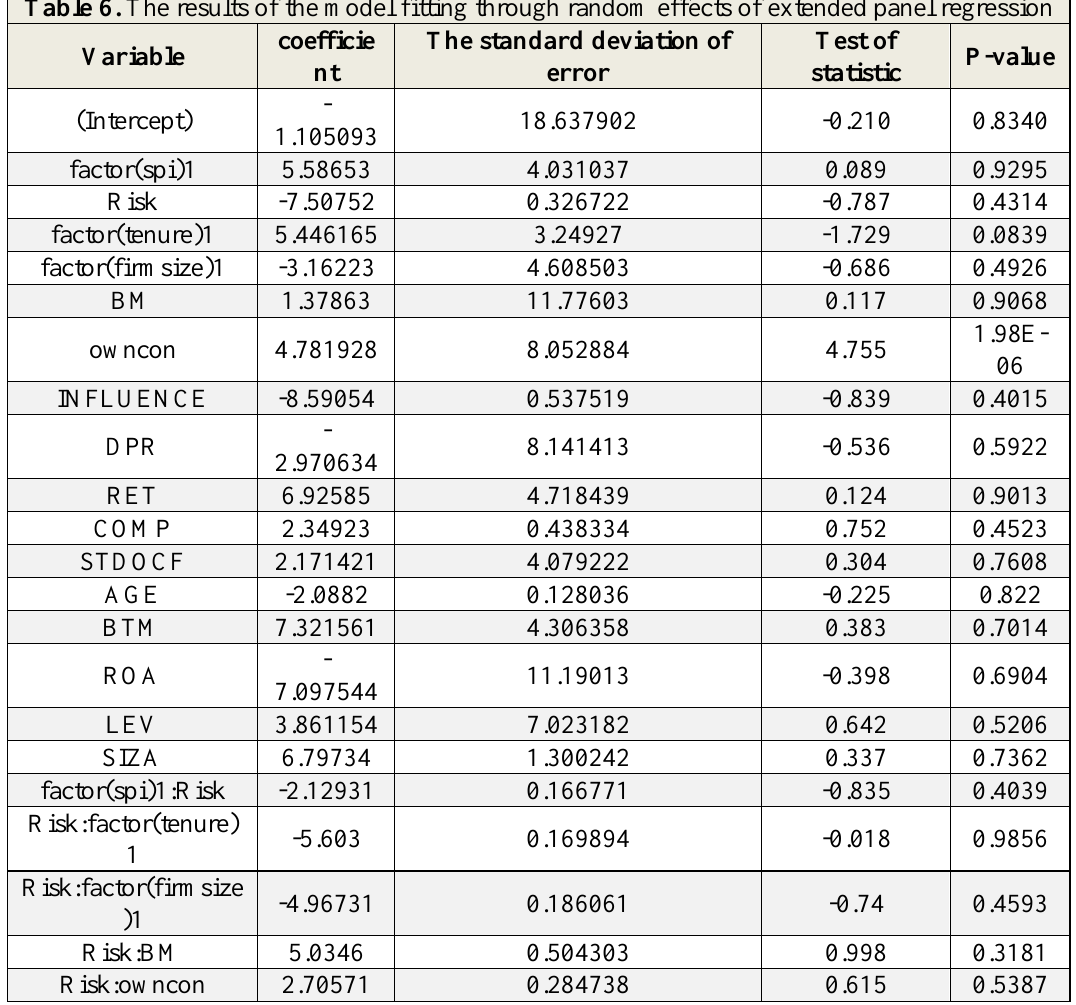
Table 6. The results of the model fitting through random effects of extended panel